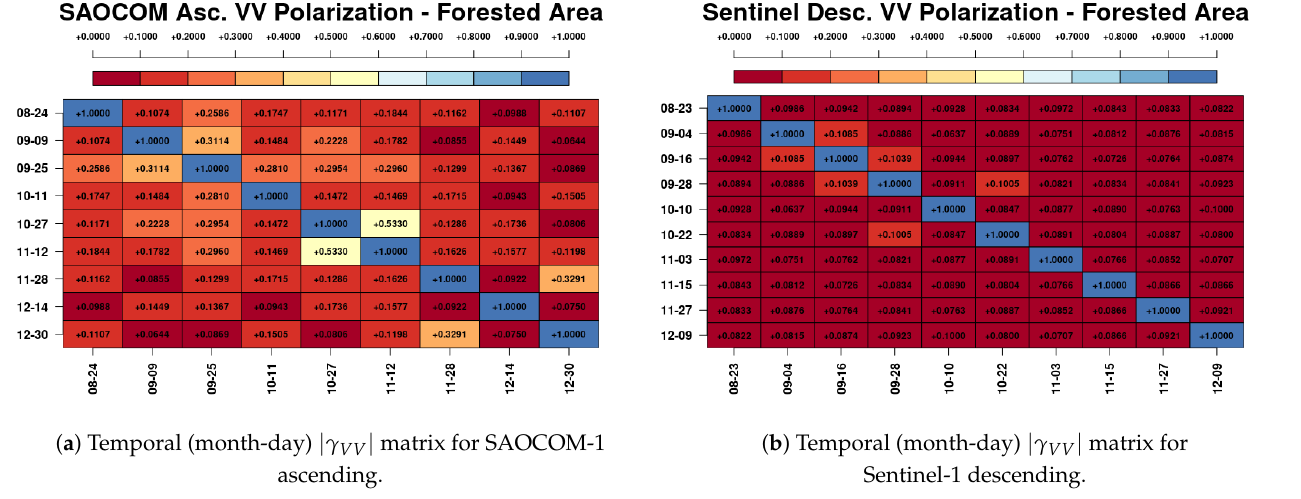
Figure 5. Forested-area , Corrientes site.